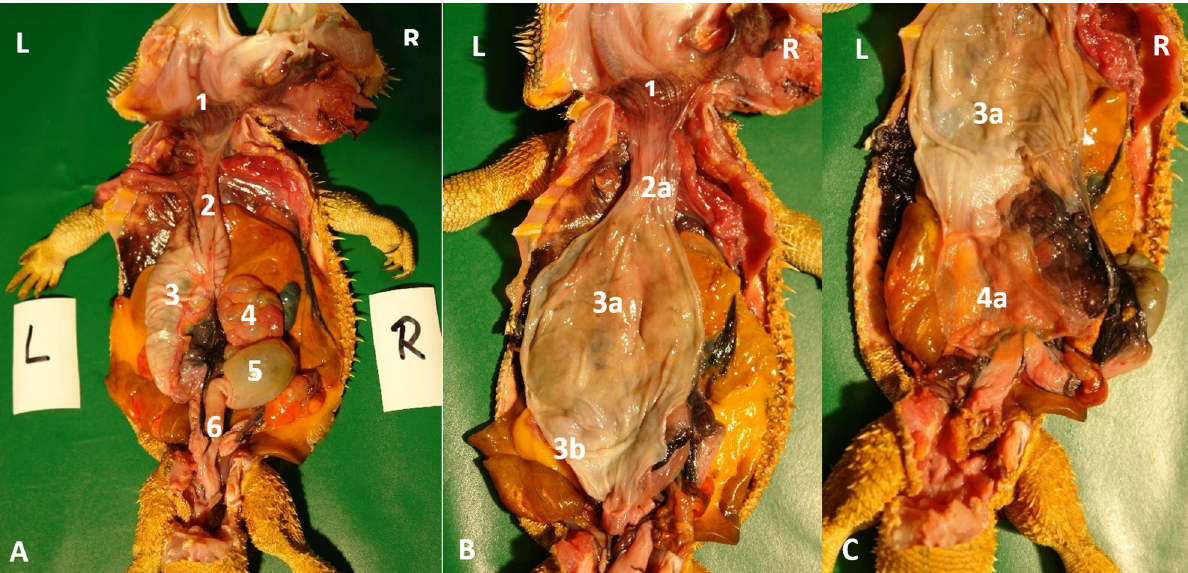
Fig 1. Topography of the alimentary canal of a female bearded dragon, dorsal view. Dorsal skin, muscles, skeleton, and serosa removed; lungs distracted cranially; and dorsal pelvis removed for an in situ view. L: left; R: right. A. Topography in situ: oral cavity and pharynx (1), esophagus (2), stomach (3), small intestine (4), ampulla coli (5), and rectum (6). B. Alimentary canal opened: oral cavity and pharynx (1), esophagus (2a), stomach (3a), and transverse gastric fold caused by angular incision (3b). C. Alimentary canal opened and distracted cranially to demonstrate the pyloric circular fold (3c � ); stomach (3a), and duodenum